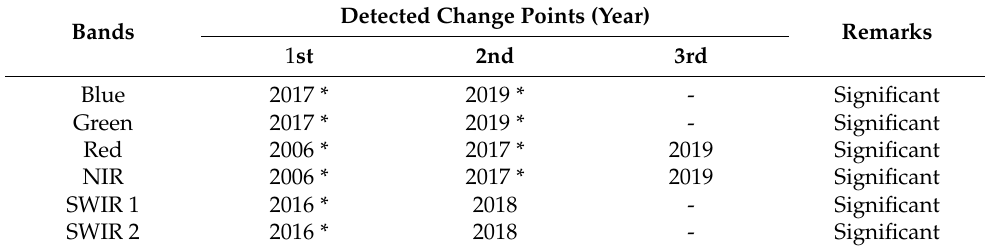
Figure 9. TOA reflectance data of the virtual constellation over Egypt 1 for blue, green, red, NIR, SWIR 1, and SWIR 2 bands with fitted trend lines before and after turning points. Table 10. Change point detection by the sequential version of the Mann–Kendall test for Egypt